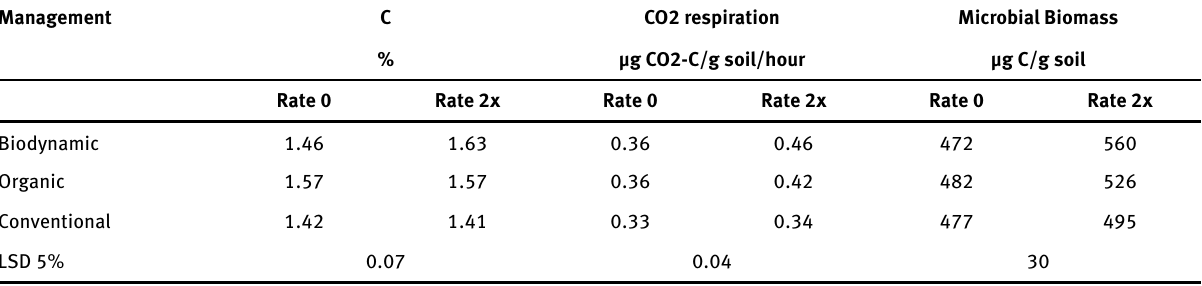
Table 3: Effects of management on soil characteristics in 1985 averaged over the B-LU-W, and B-CP-W rotations at the 0 and 2x fertilization